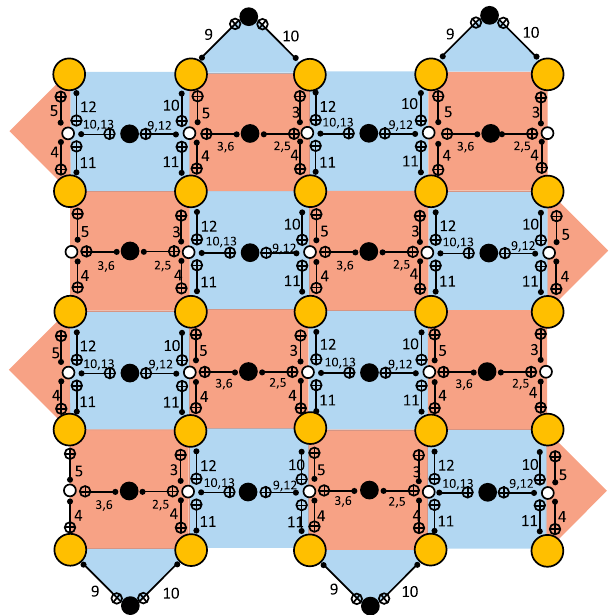
FIG. 6. Illustration of the d ¼ 5 heavy-square code with the scheduling of the CNOT gates. The data qubits are represented by yellow vertices, white vertices are the flag qubits, and the dark vertices are the syndrome measurement qubits. The red faces correspond to X -stabilizer measurements and the blue faces to Z -stabilizer measurements.